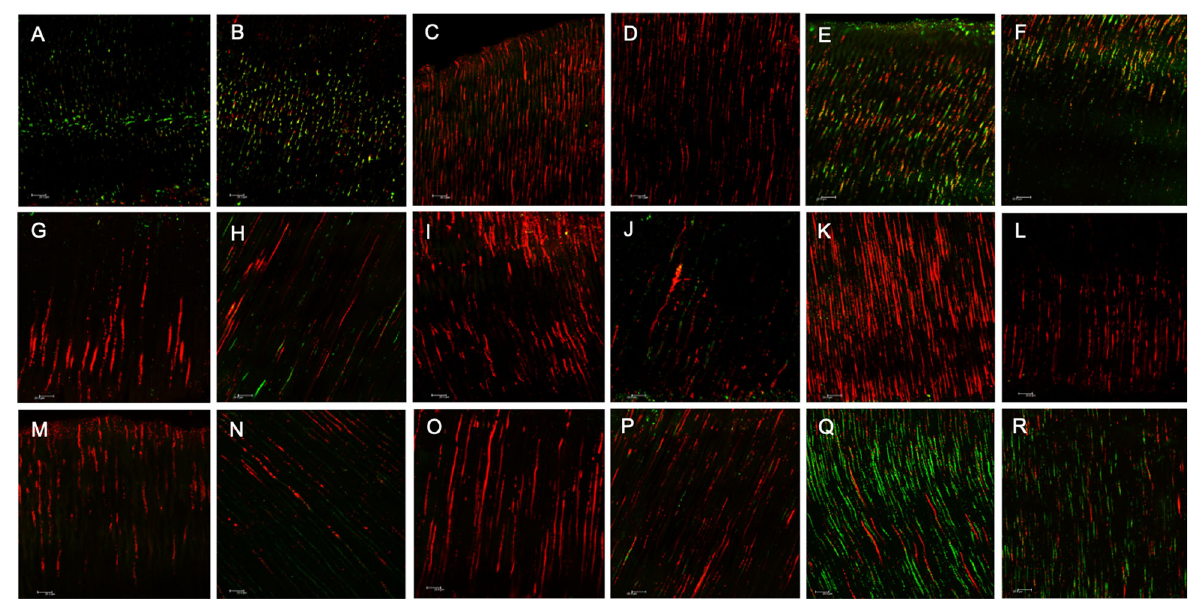
Fig. 1 Images of contaminated dentin after using the medications at the super fi cial (left column) and deep areas (right column) ( A and B ). Calcium hydroxide with the vehicle propylene glycol, 7 days (G1).